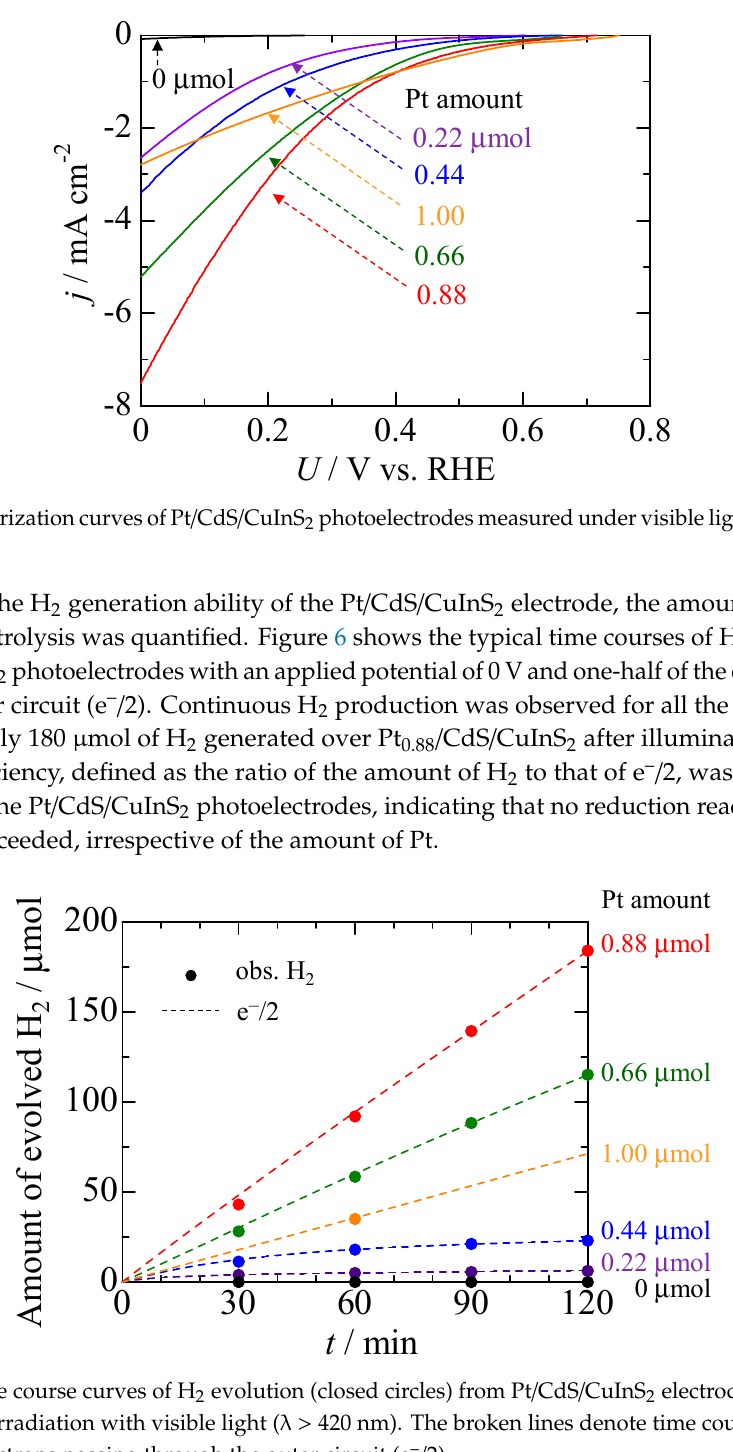
Figure 7. Current–time profiles of Pt/CdS/CuInS 2 electrodes measured at 0 V under irradiation with visible light ( λ > 420 nm). Figure 8a shows SEM images of CdS/CuInS 2 and Pt 0.88 /CdS/CuInS 2 photoelectrodes after stability tests. In the image of CdS/CuInS 2 , the disappearance of CdS and exposure of plate-like CuInS 2 particles were observed in some areas, whereas the Pt 088 /CdS/CuInS 2 electrode showed few changes other than the aggregation of Pt particles. The XPS spectra also showed evidence of the photocorrosion of CdS for the CdS/CuInS 2 electrode, with an increase in the Cu 2p and In 3d peaks being observed after photoelectrolysis (Figure 8b). In contrast, the Cu 2p and In 3d spectra of the Pt 0.88 /CdS/CuInS 2 electrode remained unchanged (Figure 8c). Therefore, Pt modification was found